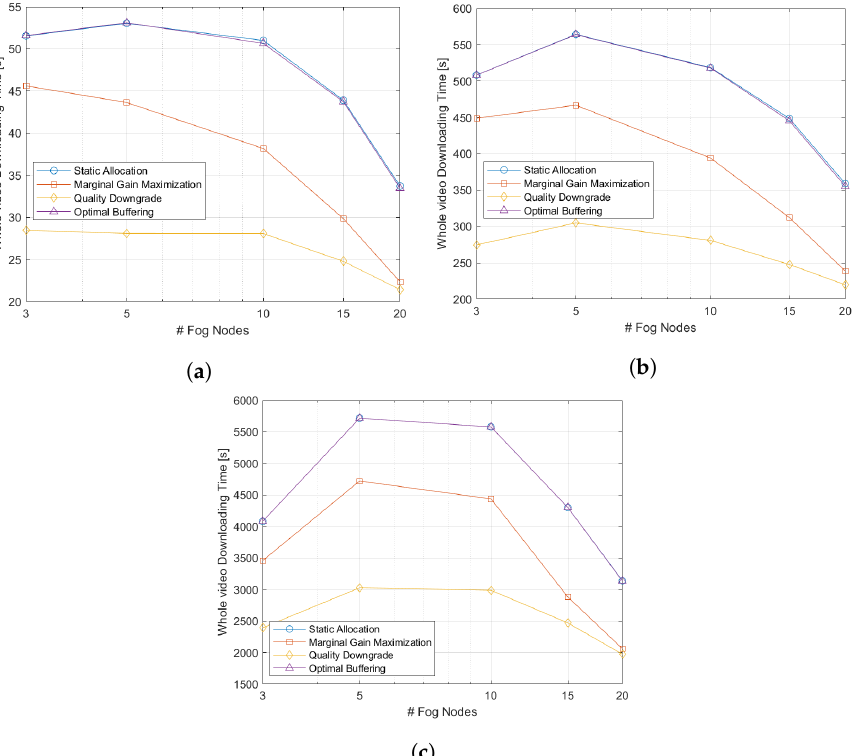
Figure 5. Average video downloading time with variable number of nodes. ( a ) Short videos. ( b ) Medium videos. ( c ) Long